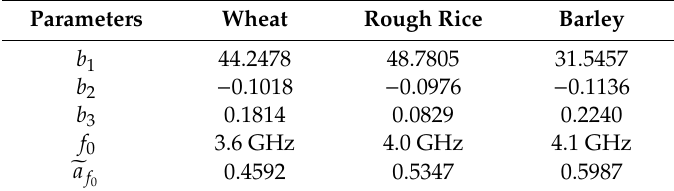
Table 2. Parameters of the function for calculating the moisture.